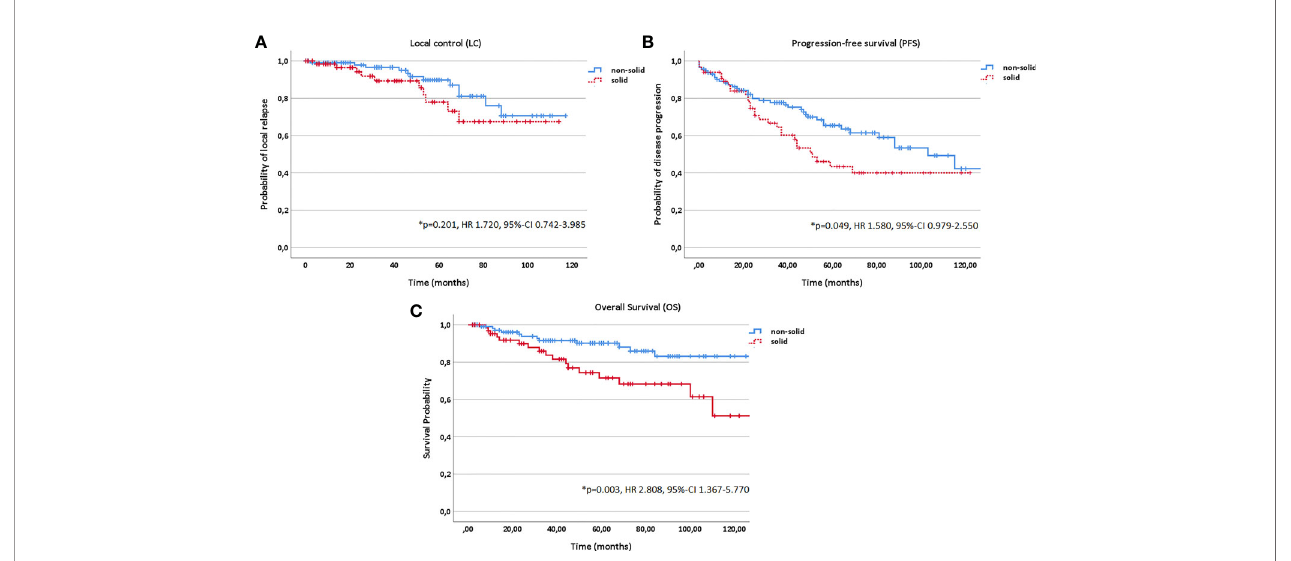
FIGURE 6 | Kaplan-Meier estimates for local control (A) , progression-free survival (B) and overall survival (C) in dependence of histology (solid vs.